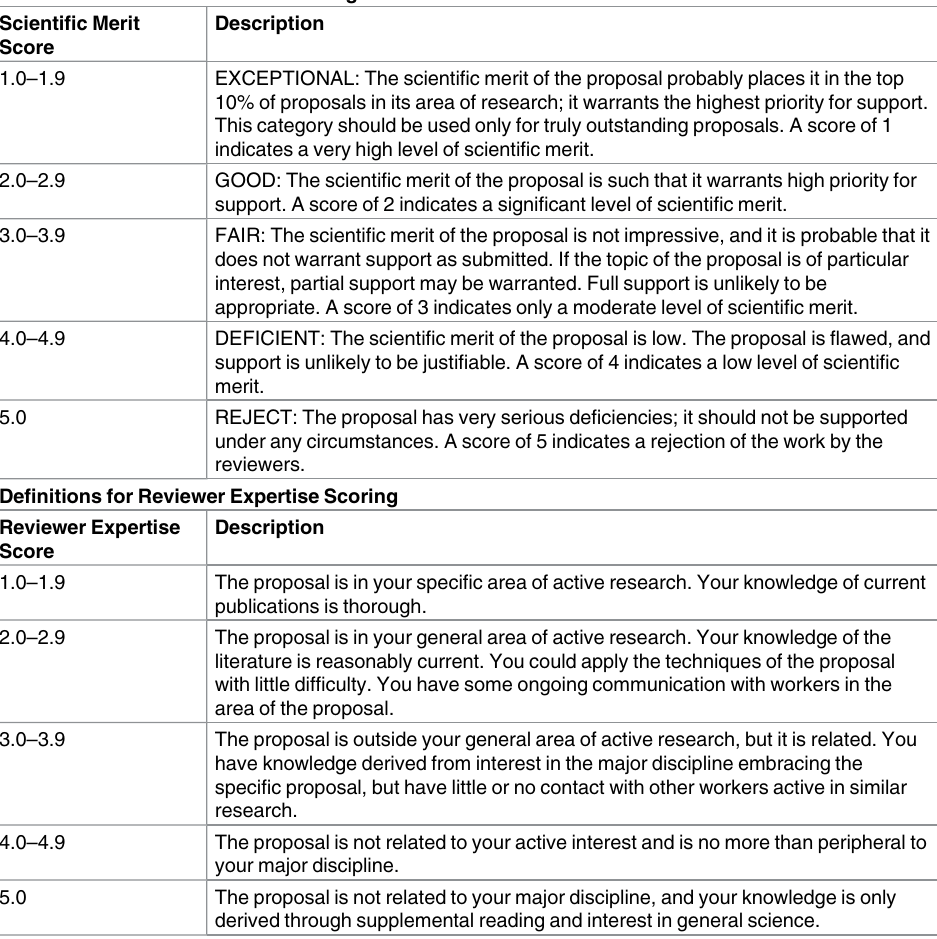
Table 1. Definitions for Scientific Merit and Reviewer Expertise